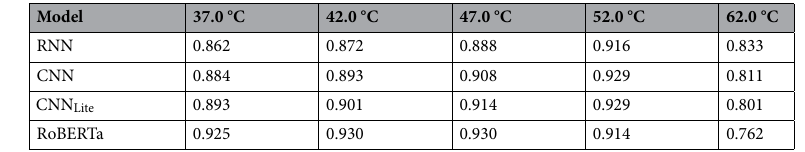
Table 1. MCC of the four deep learning models on the selected temperatures. The results suggest that the models perform reasonably well even on temperatures they were not trained